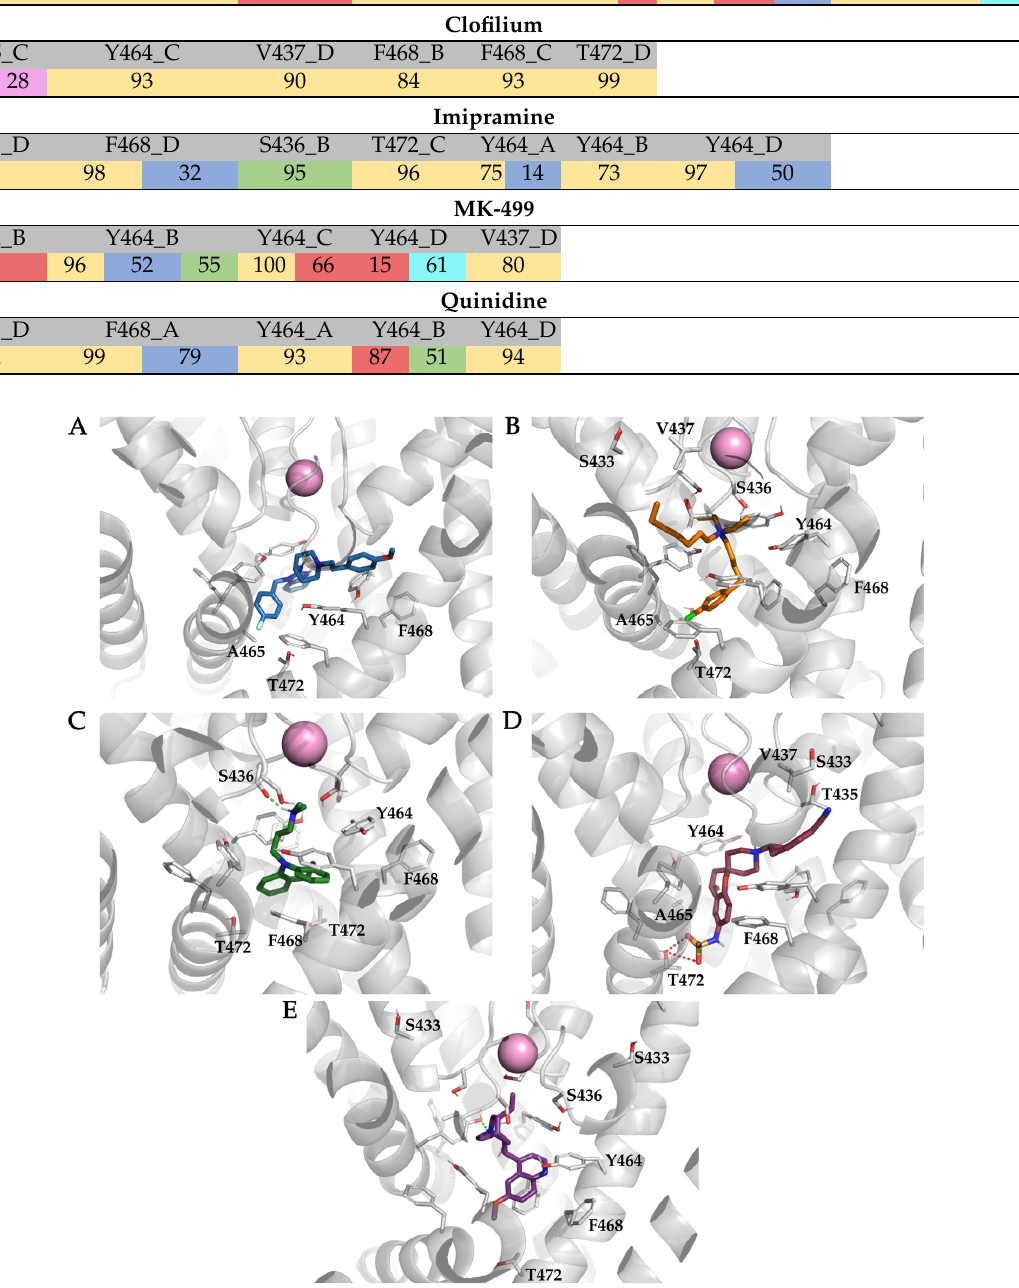
Figure 8. Stable binding poses within the homology model of the K V 10.1 open pore conformation for the ligands astemizole (( A ); blue sticks), clofilium (( B ); orange sticks), imipramine (( C ); green sticks), MK-499 (( D ); pink sticks), and quinidine (( E ); magenta sticks) from the last 20 ns of the simulations. The K V 10.1 amino-acid residues reported in the literature as important for the binding of the ligands used in this study are labeled and shown as gray sticks. Potassium ions are shown as pink spheres. Hydrogen bonds are shown as green (hydrogen bond donors) and red dashed lines (hydrogen bond acceptors).